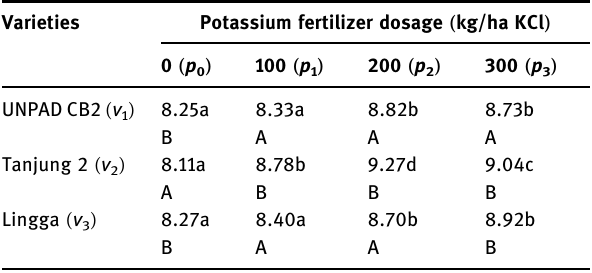
Table 3: E ff ect of interaction between dosage of potassium fertilizer and red chili varieties on stem diameter at 8 WAP Varieties